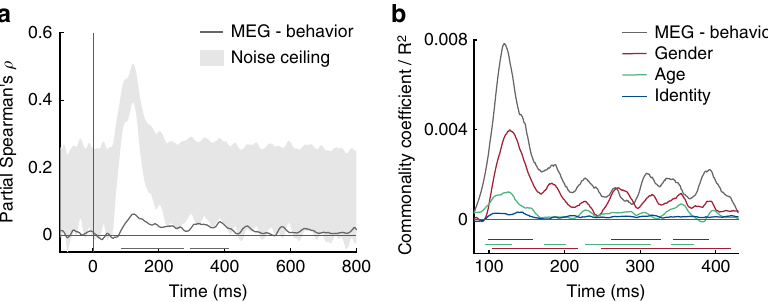
Fig. 4 MEG and behavioral RDM comparisons. a Time course of correlation (partial Spearman, partialling out low-level features) between behavioral and MEG RDMs ( n = 14). Gray-shaded area indicates estimated noise ceiling based on the variability across subjects. b Model-based commonality analysis showing the portion of shared variance between MEG and behavior (gray line) uniquely explained by gender (i.e., commonality coef fi cient; red), age (green) and identity (blue). Note that this analysis was restricted to the time window of the signi fi cant correlation between MEG and behavior (as shown in a ). Colored lines below plots indicate signi fi cant times using cluster-based sign permutation test (cluster-de fi ning threshold p < 0.05, and corrected signi fi cance level p < 0.05). Source data are provided as a Source Data fi